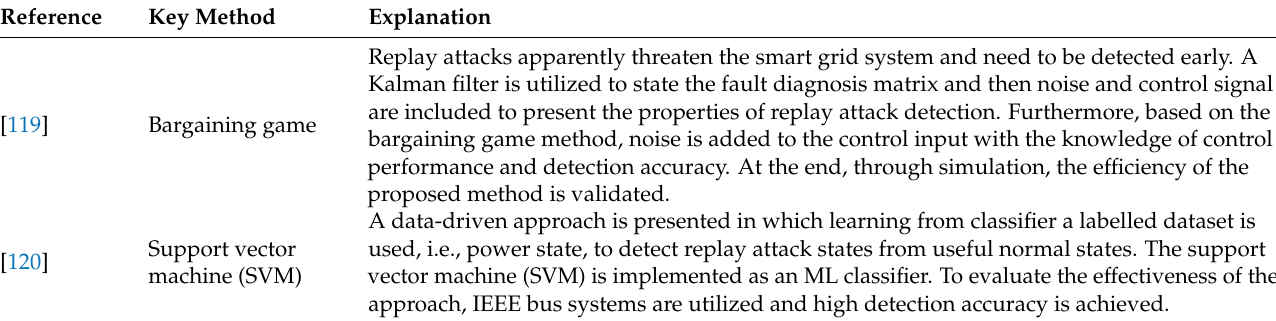
Table 9. Methods and countermeasures to defend against replay